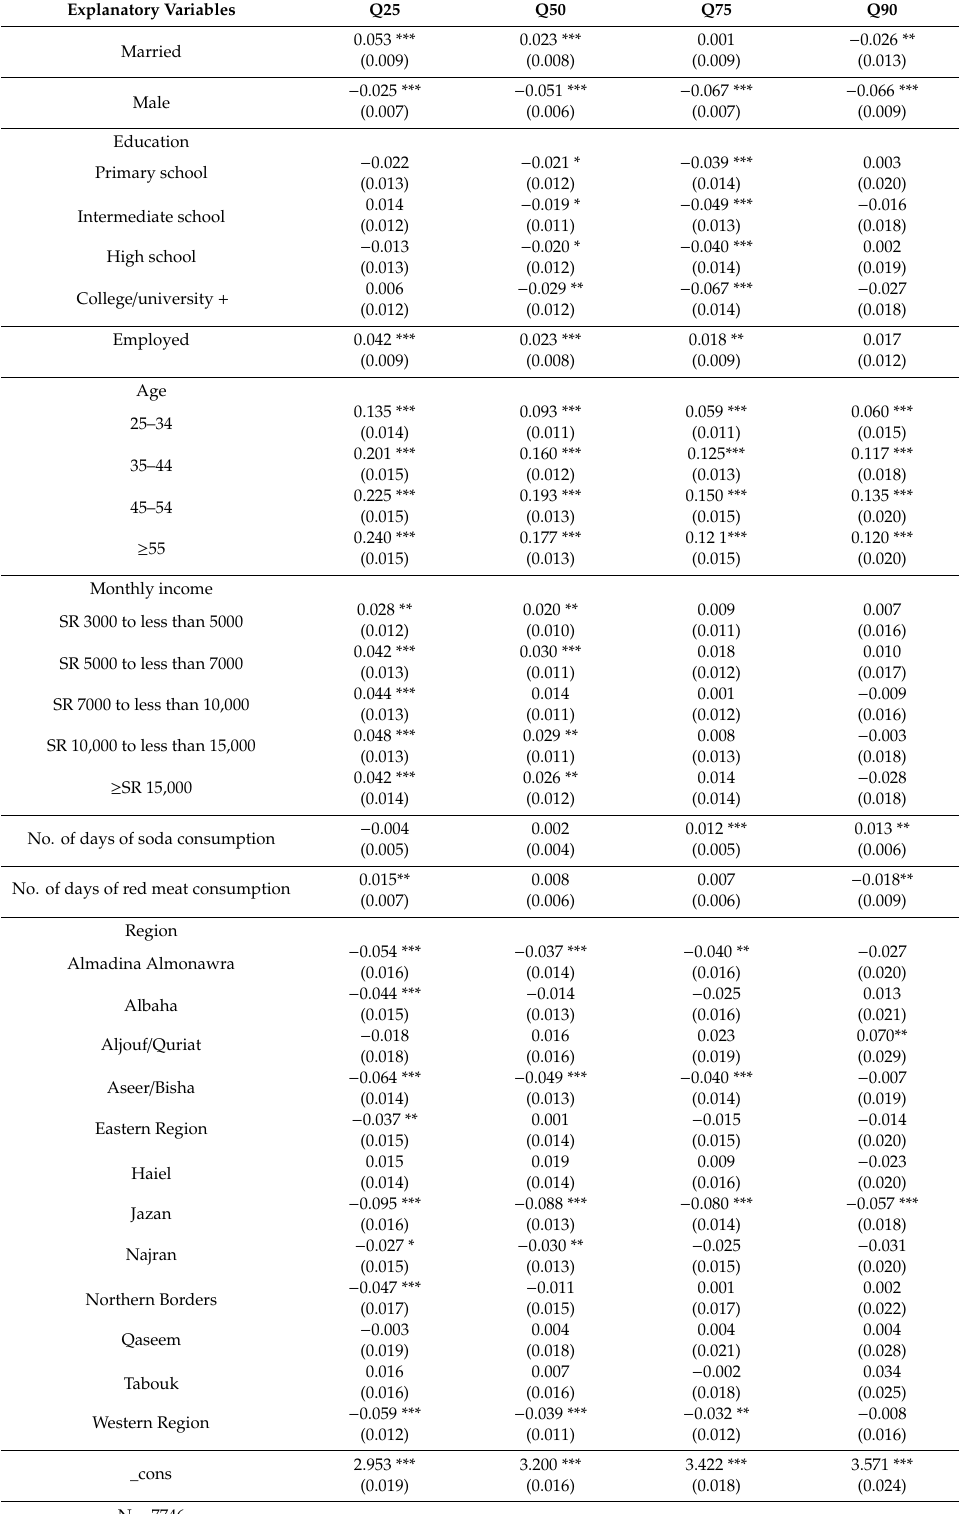
Table 2. Regression results for gender–BMI distribution (unconditional distribution). Results from the 2013 Saudi Health Interview Survey